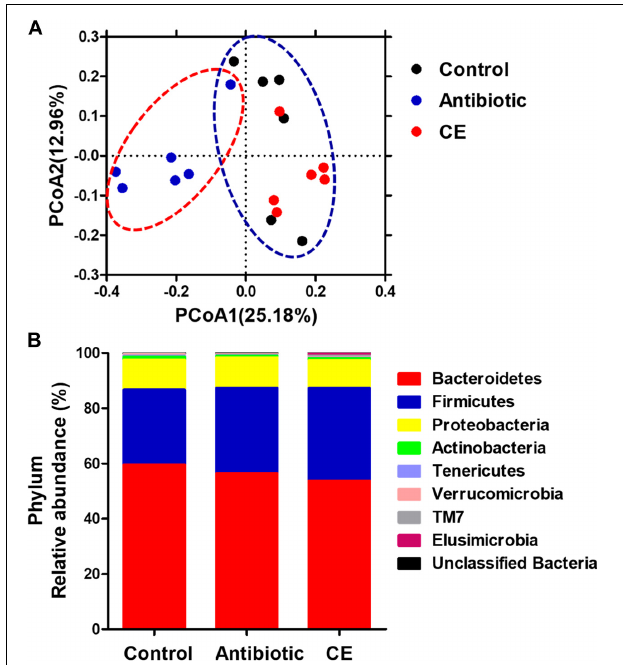
FIGURE 1 | (A) Principal coordinates analysis (PCoA) of bacterial communities in the cecal digesta of Chinese yellow-feathered broilers (based on the Bray–Curtis distance). Circles with dashed or solid line indicate that groups were significantly distinct using AMOVA ( P < 0.05). (B) Phylum-level relative abundance of 16S rRNA gene sequences from the cecal digesta of Chinese yellow-feathered broilers. CE, citrus extract; AMOVA, analysis of molecular variance.